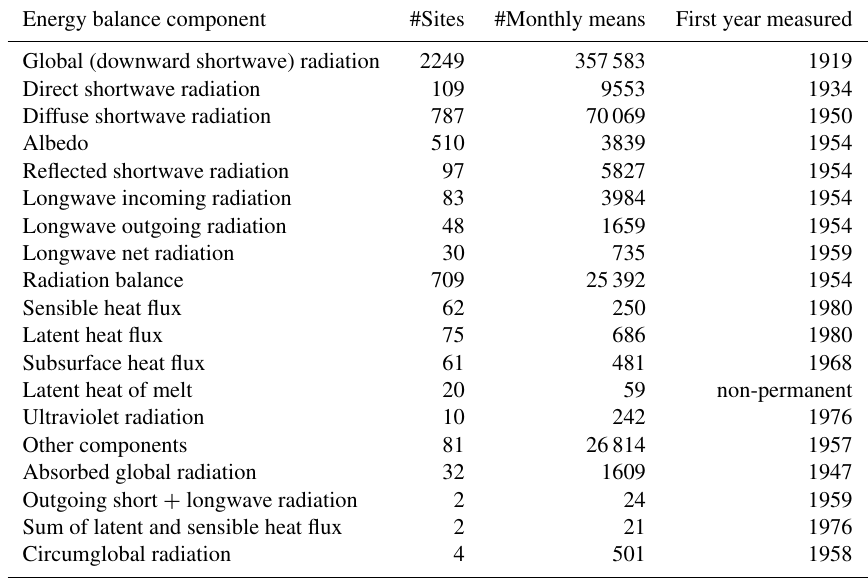
Table 1. List of the various energy balance components included in GEBA, with the number of sites measuring each component, the number of monthly values included, and the earliest year that has data for each component in